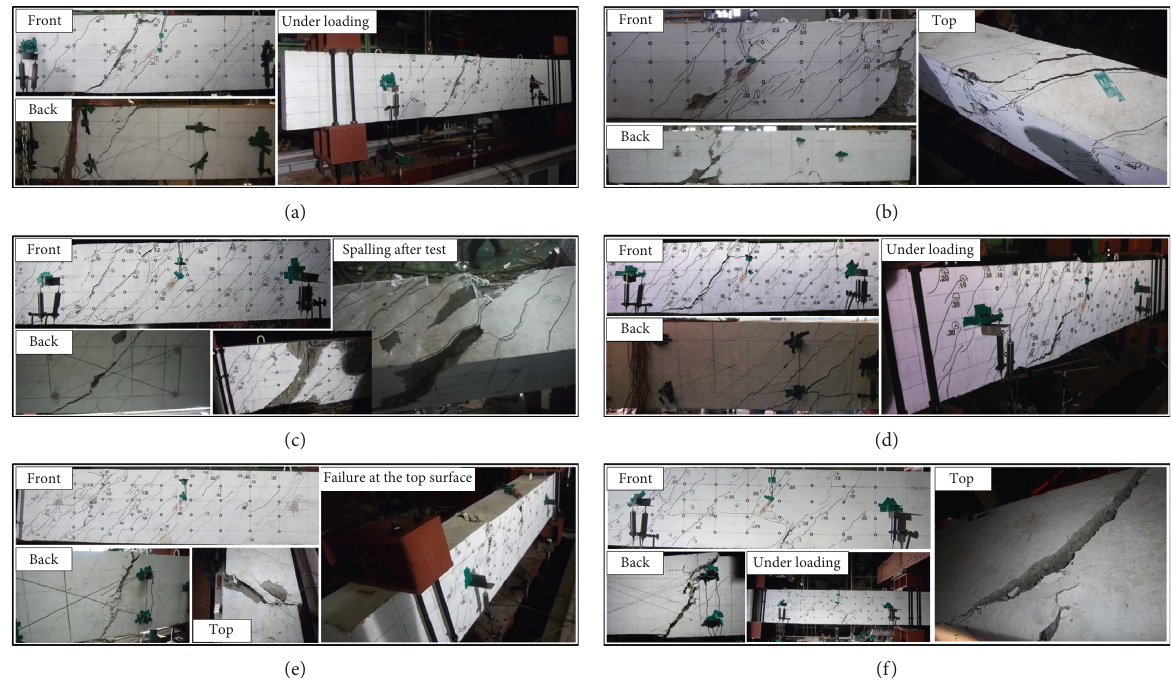
Figure 3: Crack pattern and failure of specimens: (a) MT30-0.77; (b) MT30-1.32; (c) MT40-1.32; (d) MT40-1.89; (e) MTF25-0.77; (f) MTF25-N.